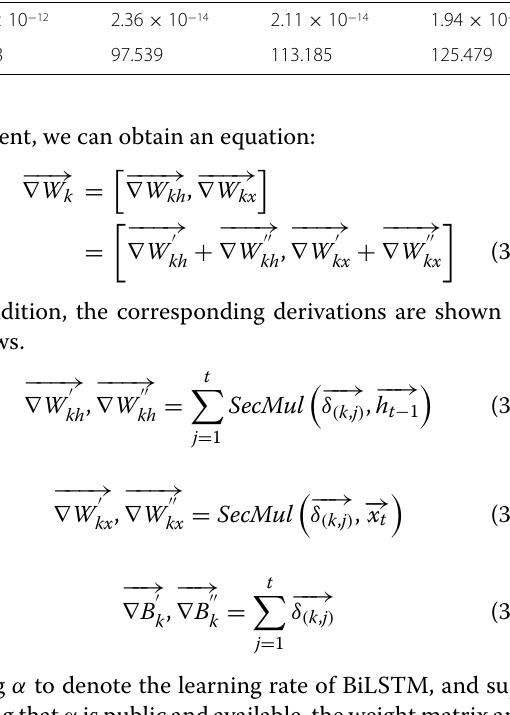
Table 2 Comparison of error and time according to different sigmoid piecewise-linear functions The number of piecewises